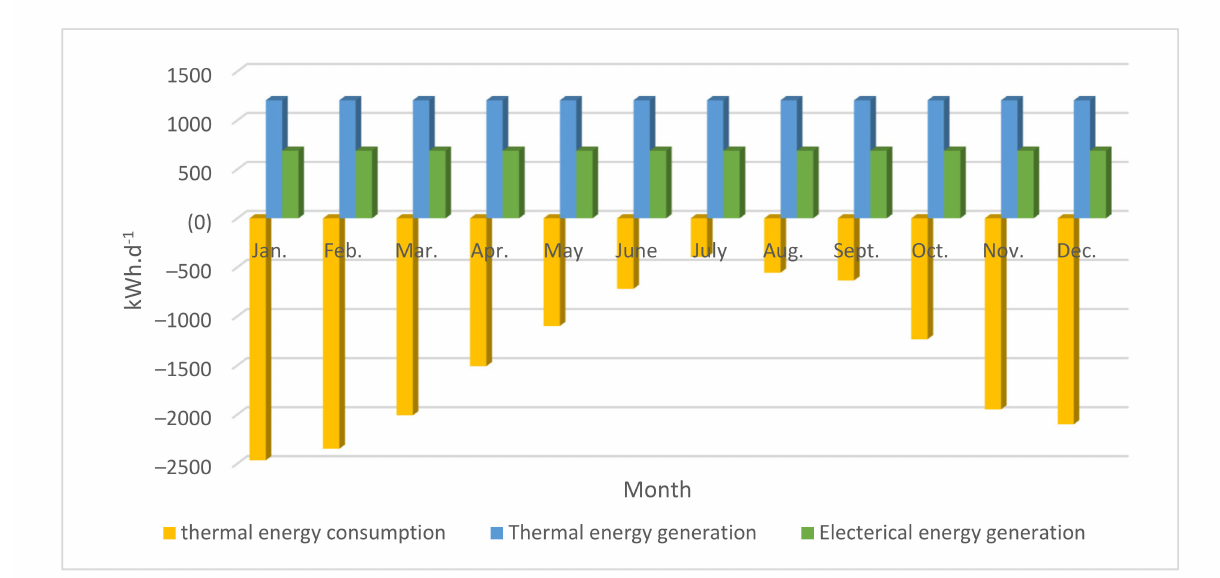
Figure 6. Anaerobic digestion energy generation and consumption.